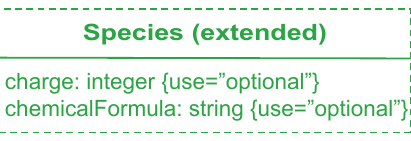
Figure 2: A UML representation of the extended SBML Species class used in the Flux Balance Constraints package. See Section 1.4 for conventions related to this figure.